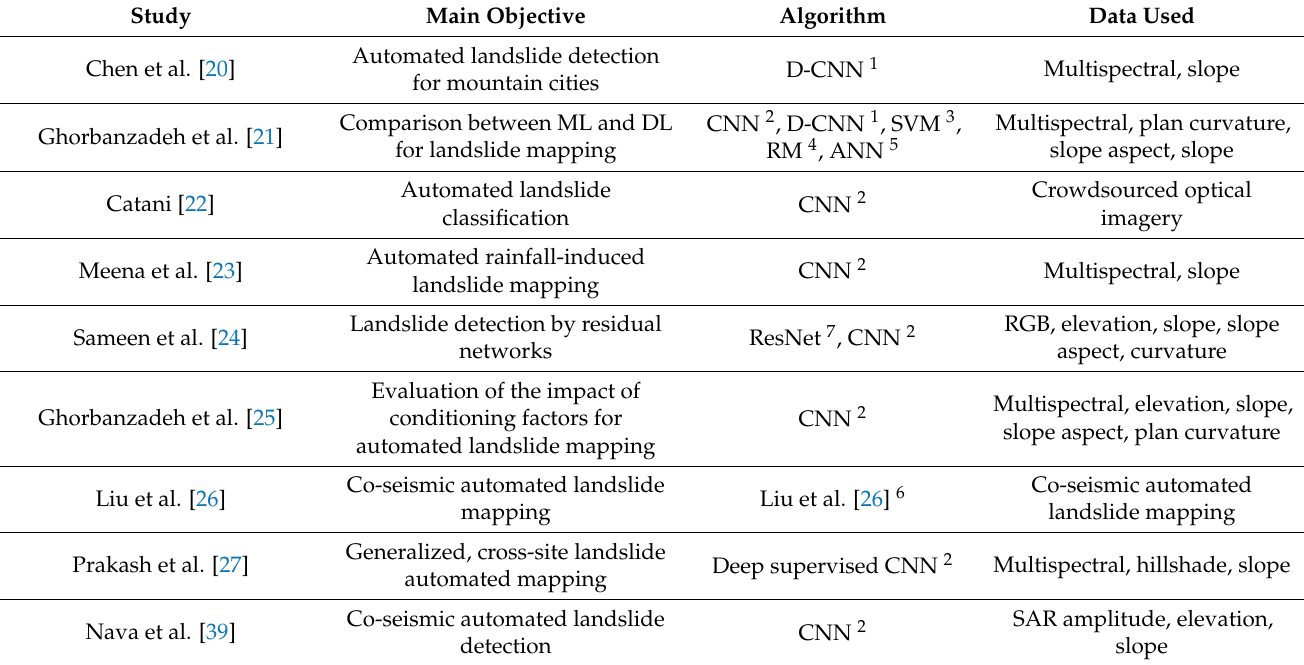
Table 1. Recently published studies on landslide detection, classification, and mapping using Deep Learning